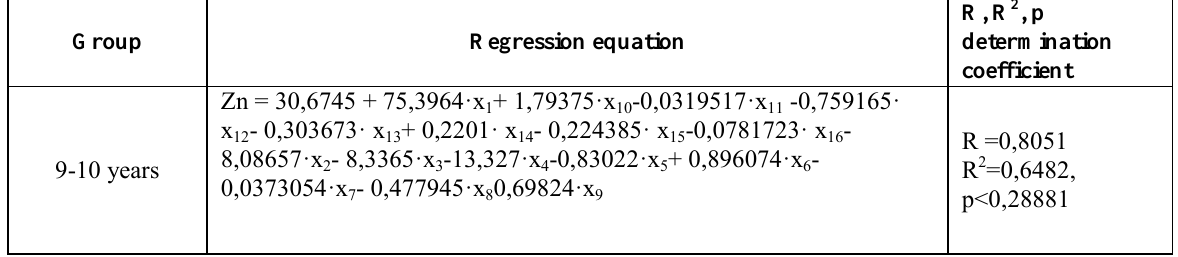
Competitive Performance-Psychophysiological Data Equation of Stepwise Regression Group Regression